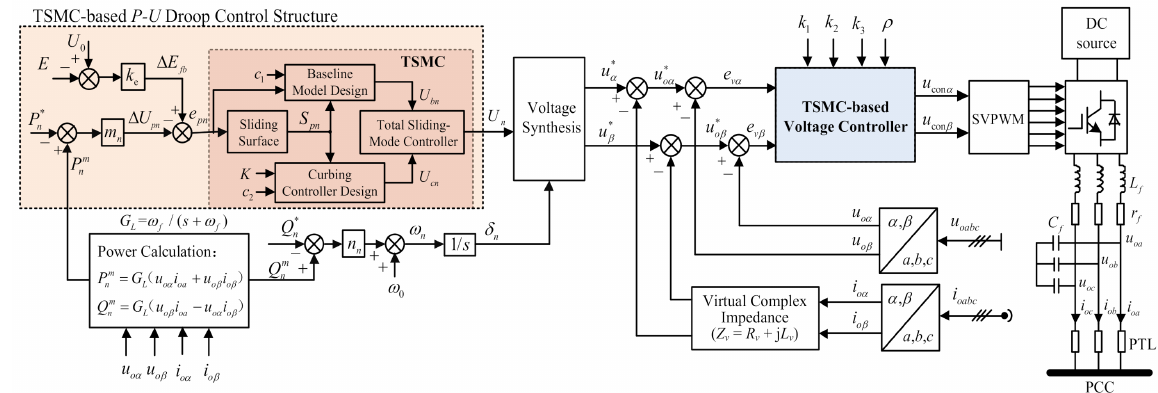
Figure 2. Diagram of proposed control